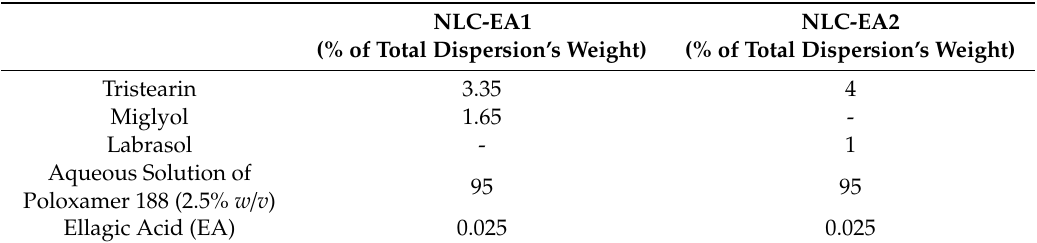
Table 2. Composition of the produced nanostructured lipid carriers